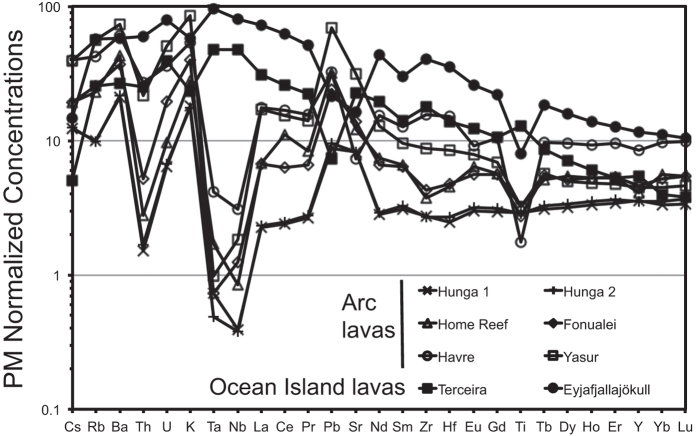
Primitive mantle-normalized incompatible element concentrations for samples listed in Table 1 from the island arcs and ocean islands illustrating the wide-ranging compositions analyzed here.See Fig. 1 and the text for sample locations.